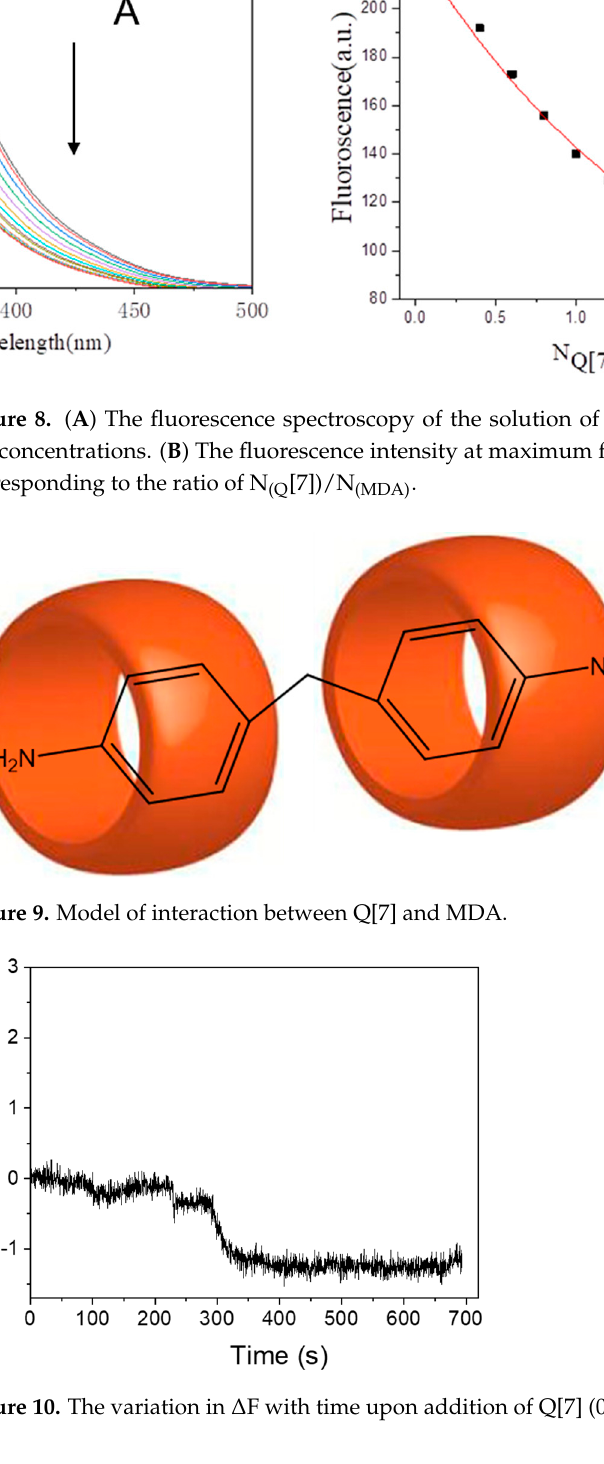
Figure 8. ( A ) The fluorescence spectroscopy of the solution of MDA with adding Q[7] at different concentrations. ( B ) The fluorescence intensity at maximum fluorescence emission wavelength cor- responding to the ratio of N (Q[7]) /N (MDA) .